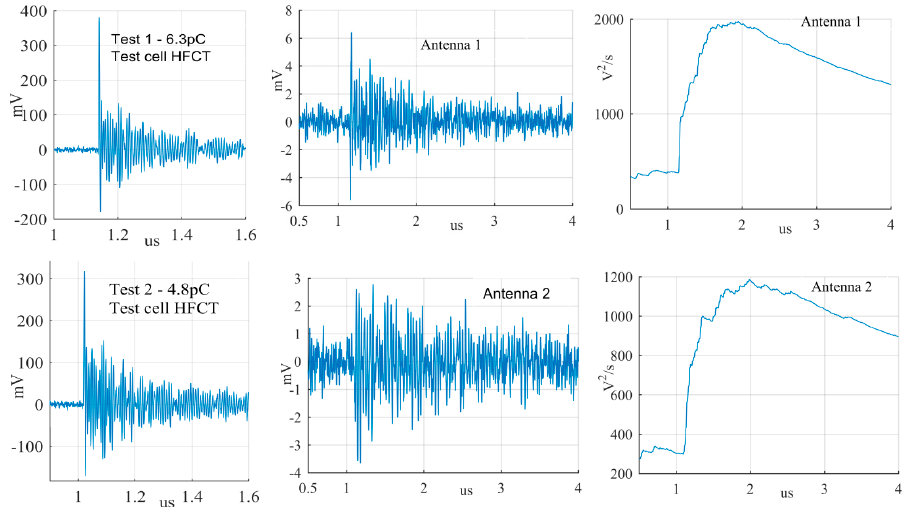
Figure 12. Largest corona discharge from the antenna at position 1 and 2.